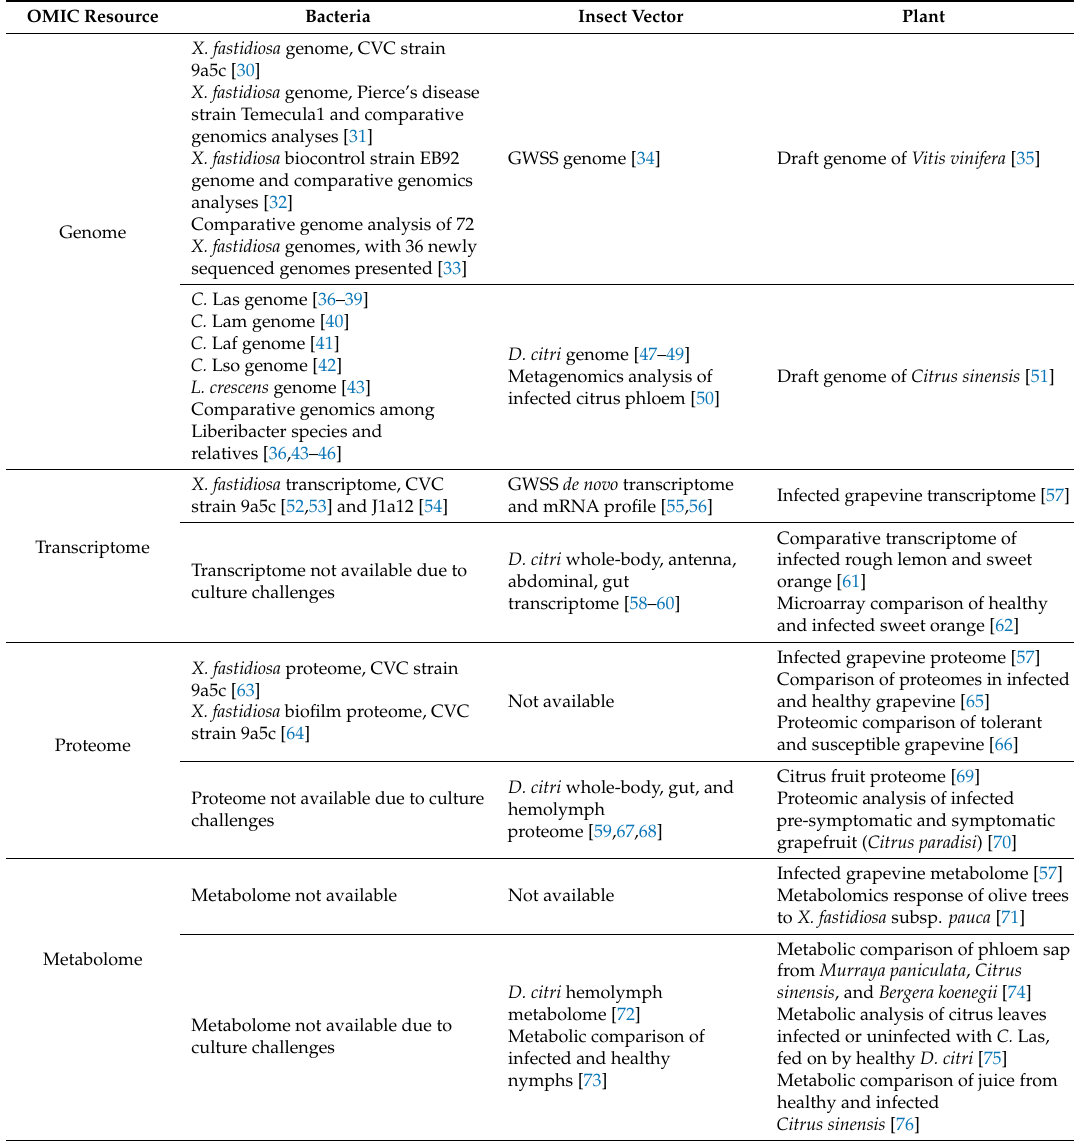
Table 2. Selected OMICs